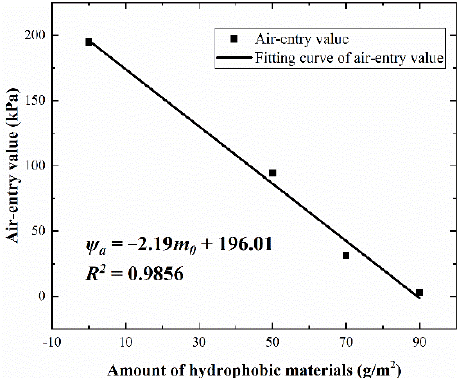
Figure 12. Fitting curve of air-entry value after hydrophobic treatment with different dosages in 2 h.